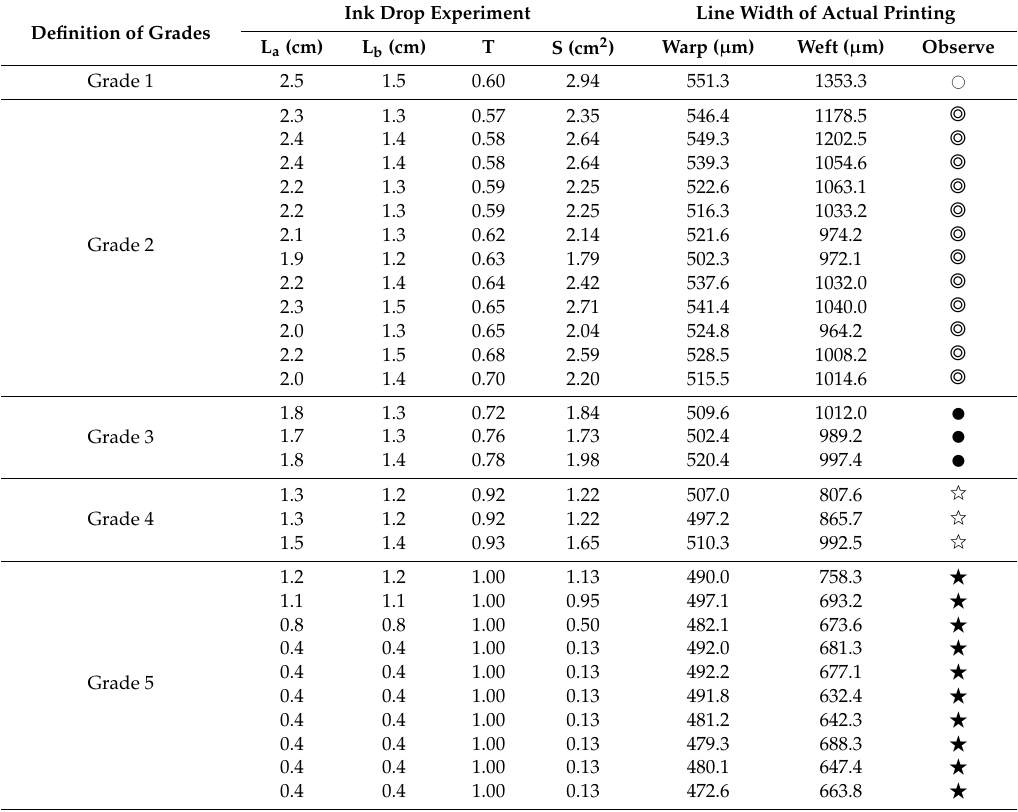
Table 2. Relation of ink drop experiment and line width of actual